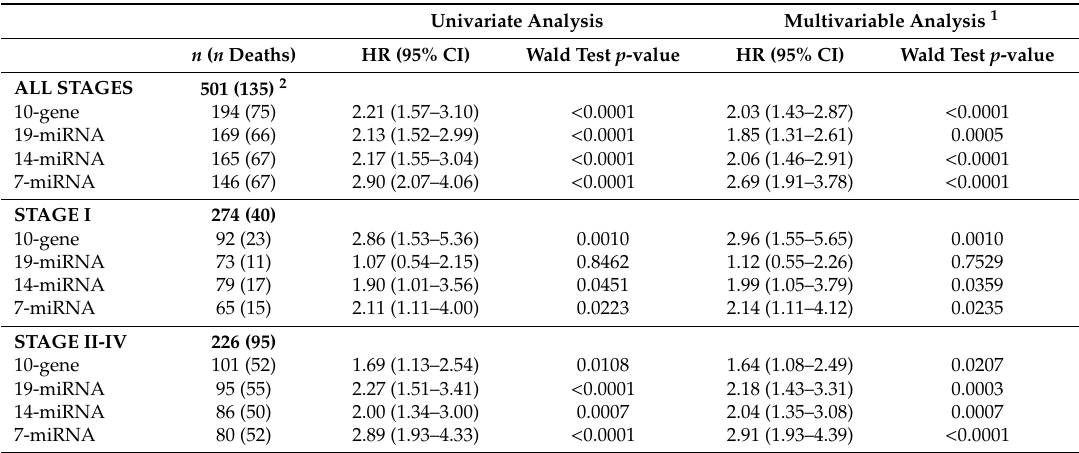
Table 3. TCGA-LUAD cohort. Univariate and multivariable Cox regression analyses for 3-years overall survival in patients of all stages and stratified by